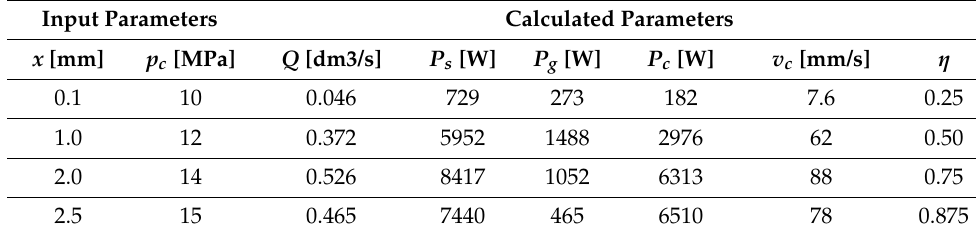
Table 1: L = 6 mm—orifice length, Q —flow, P s —supply power, P g , e.g., P SA + P SB or P AT + P BT —power losses on a two valve gaps, v c —piston velocity, and η —power efficiency,. The best efficiency is obtained when the flow slots of the valve are as open as possible. Table 1. Parameters of the drive for different spool displacements and piston